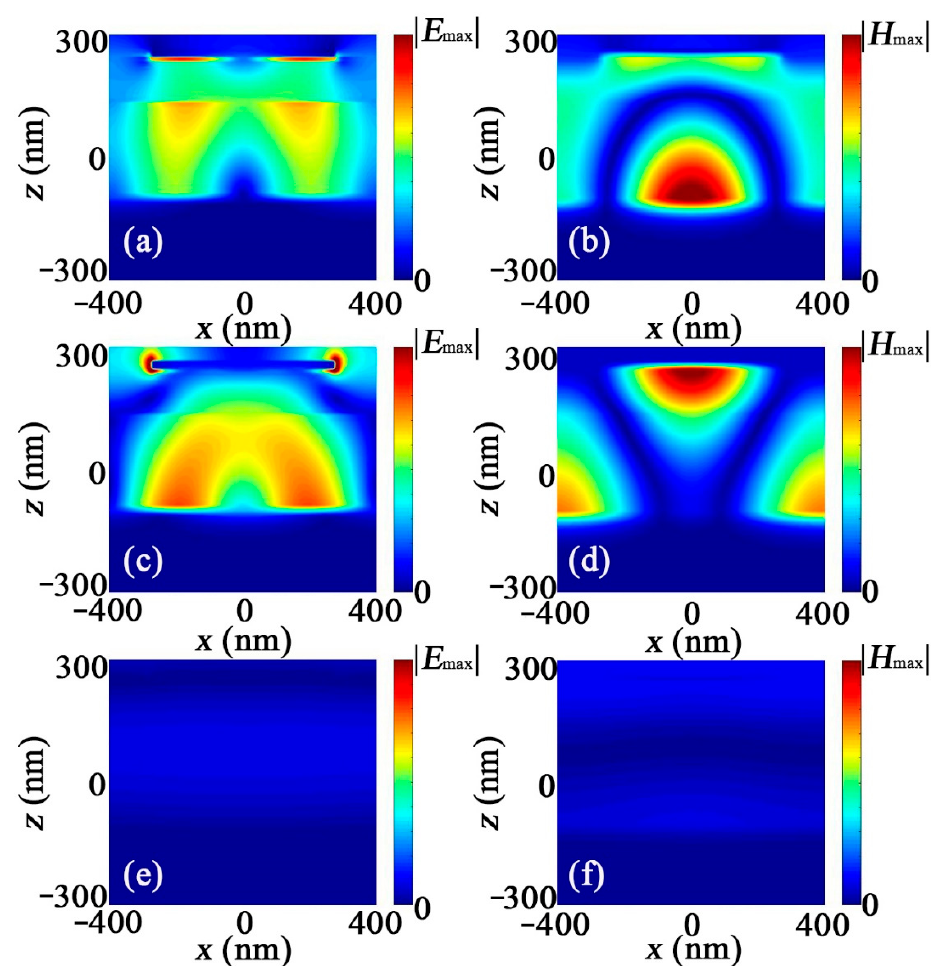
Figure 4. Contour profiles of normalized field of the structure under p-polarized incident light. ( a ) Electric and ( b ) magnetic fields at λ 1 = 1291 nm. ( c ) Electric and ( d ) magnetic fields at λ 2 = 1548 nm. ( e ) Electric and ( f ) magnetic fields at λ 3 = 1400 nm.